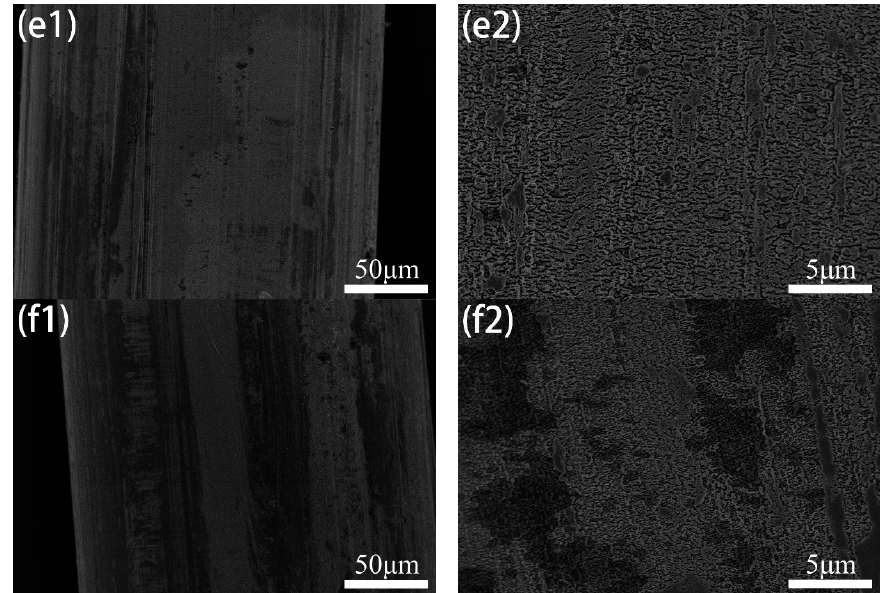
Figure 2. SEM images: of untreated POM fiber ( a1 , a2 ); and fiber subjected to DBD plasma treatment for: 30 s ( b1 , b2 ); 60 s ( c1 , c2 ); 90 s ( d1 , d2 ); 120 s ( e1 , e2 ); and 180 s ( f1 , f2 ).